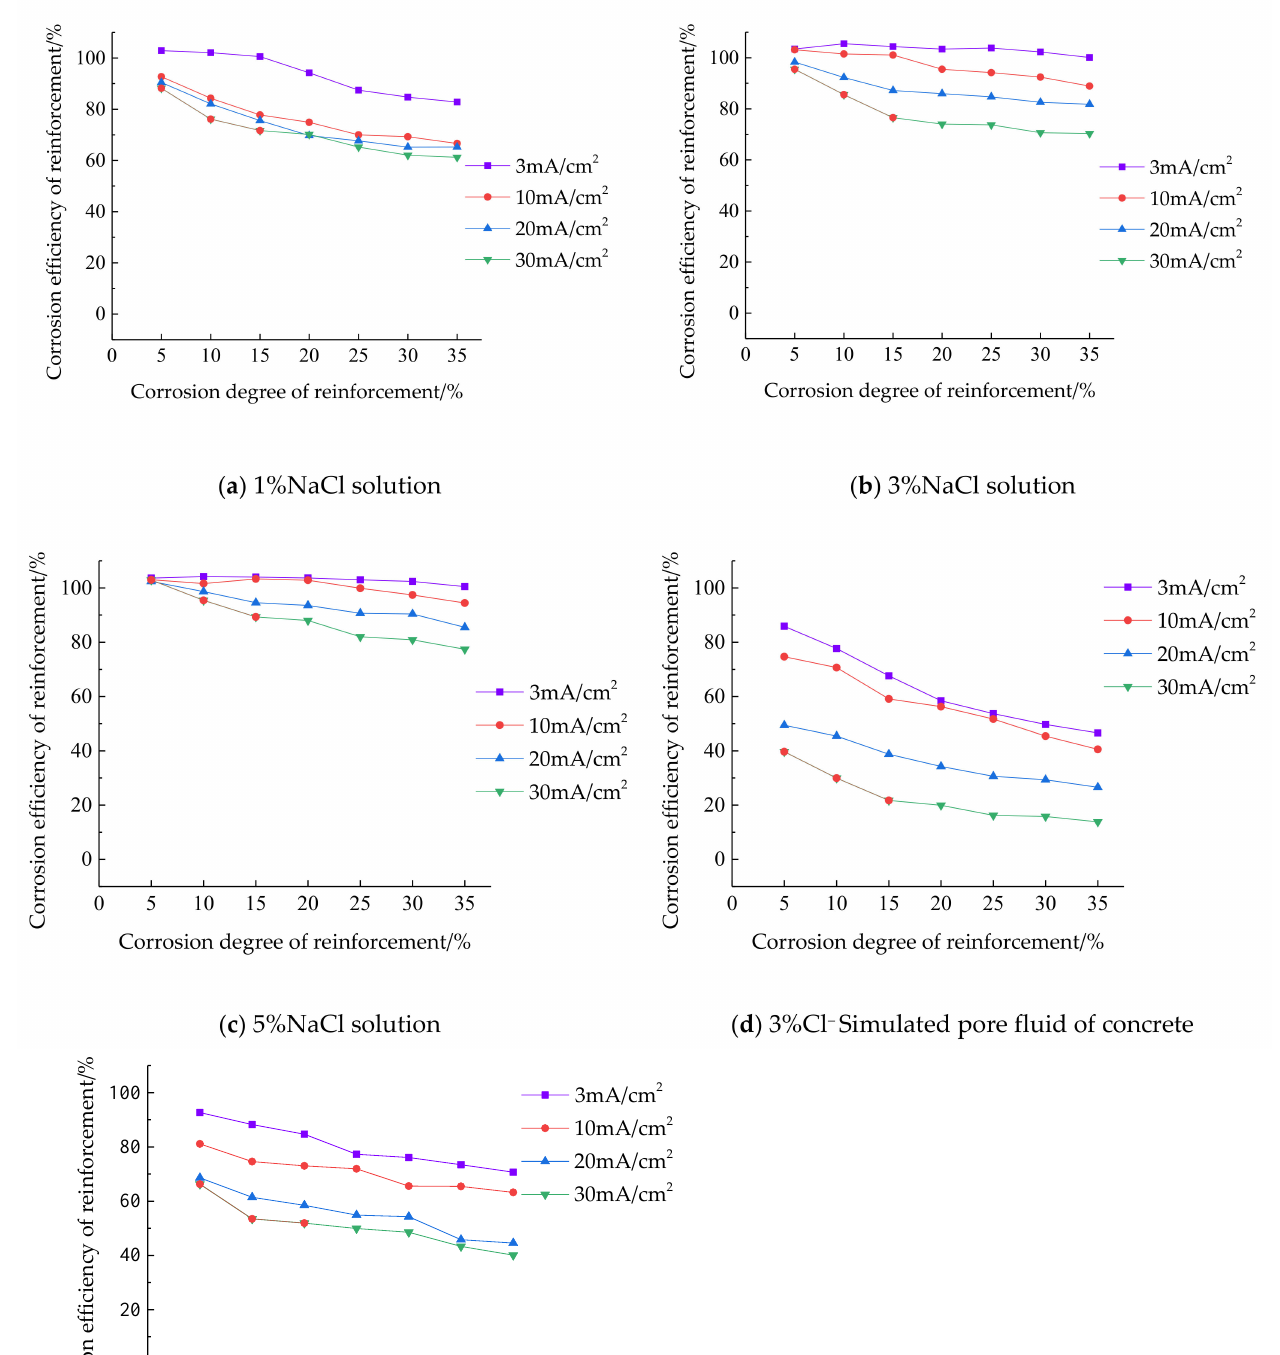
Figure 4. Influence of current density change on corrosion efficiency of reinforcement. ( a ) The corrosion efficiency of reinforcement under 1%NaCl solution; ( b ) The corrosion efficiency of reinforcement under 3%NaCl solution; ( c ) The corrosion efficiency of reinforcement under 5%NaCl solution; ( d ) The corrosion efficiency of reinforcement under 3%Cl − Simulated pore fluid of concrete; ( e ) The corrosion efficiency of reinforcement under 5%Cl− Simulated pore fluid of concrete .